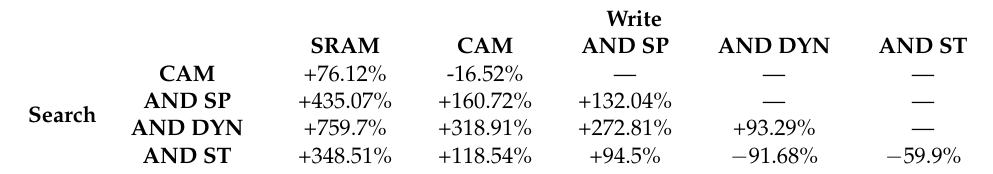
Table 9. Percentage differences between the read and search energy-delay products among the arrays. Each value corresponds to the increase, expressed in percentage, in the energy-delay product of the memory on the corresponding row with respect to the one of the memory on the corresponding column. The data are extracted from Table 3.